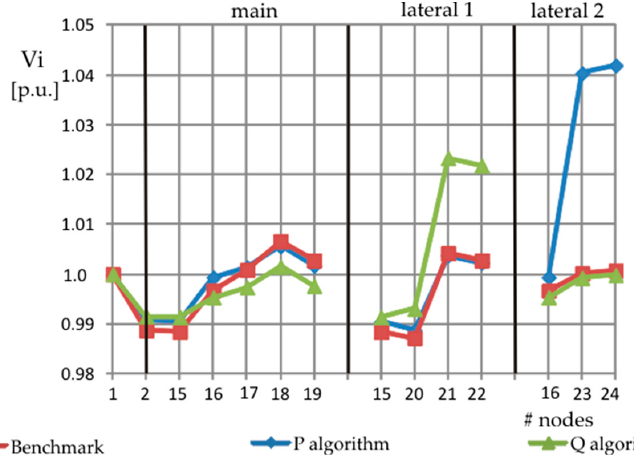
Figure 13. Voltage profiles of Benchmark and proposed VOP with four VCZs for Case R ≈ X — DG: feeder 2.